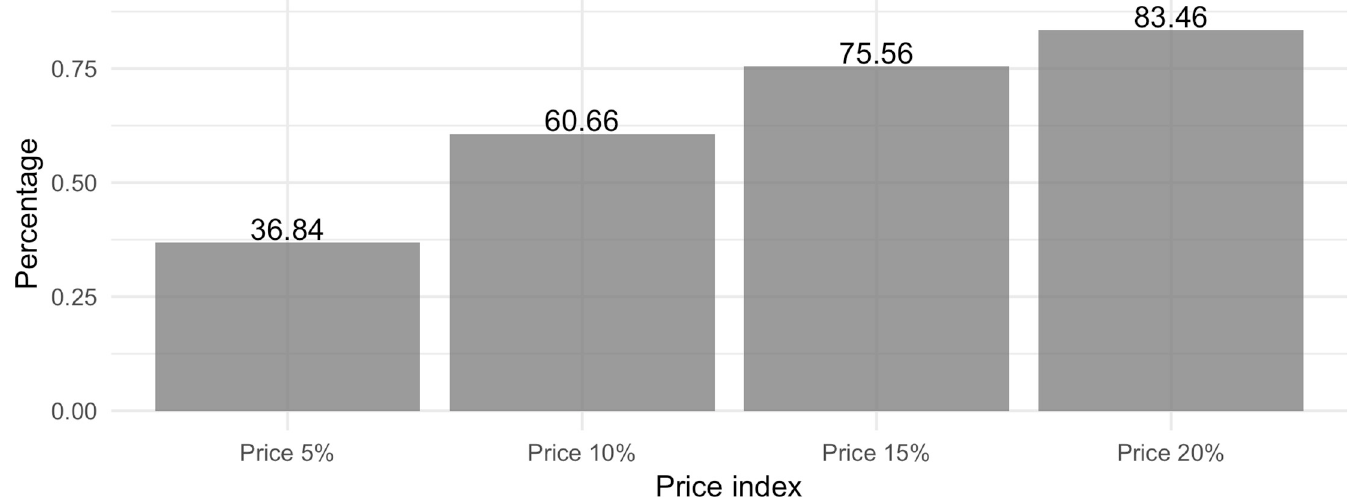
Fig 4. Literature obsolescence of Wikipedia article references using the Price index for 5, 10, 15 and 20 years.